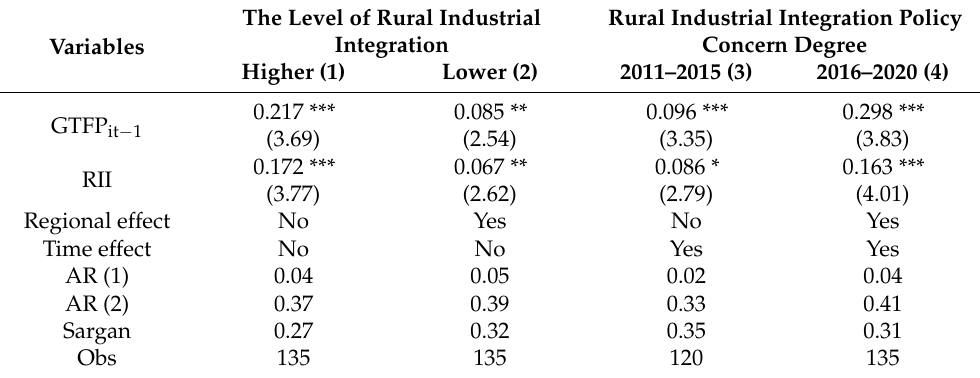
Table 7. Heterogeneity test based on the level of rural industrial integration and the degree of policy attention. The Level of Rural Industrial Rural Industrial Integration Integration Variables